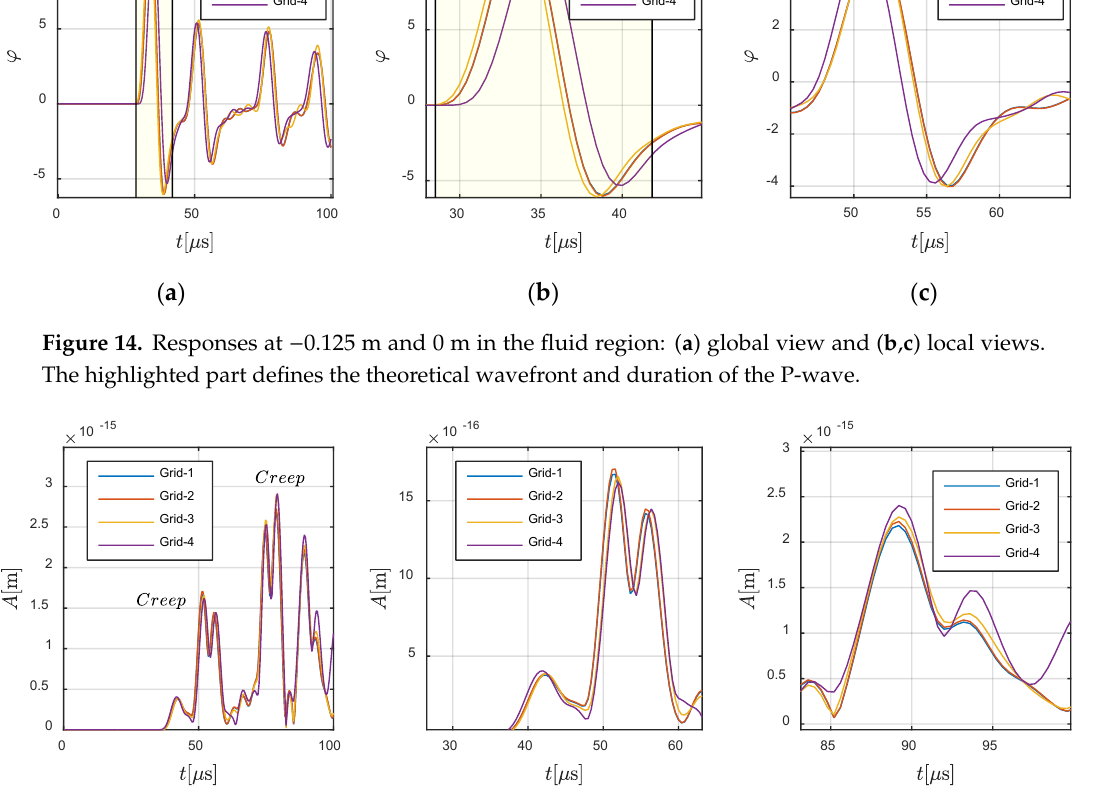
Figure 15. Responses at 0 m and 0.0625 m in the solid region: ( a ) global view and ( b , c ) local views.